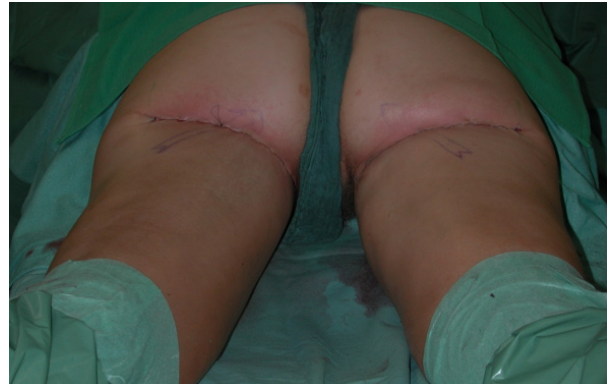
Figure 13. Underminig and anchoring to the ischial tuberosity or deep fascia using resorbable sutures.